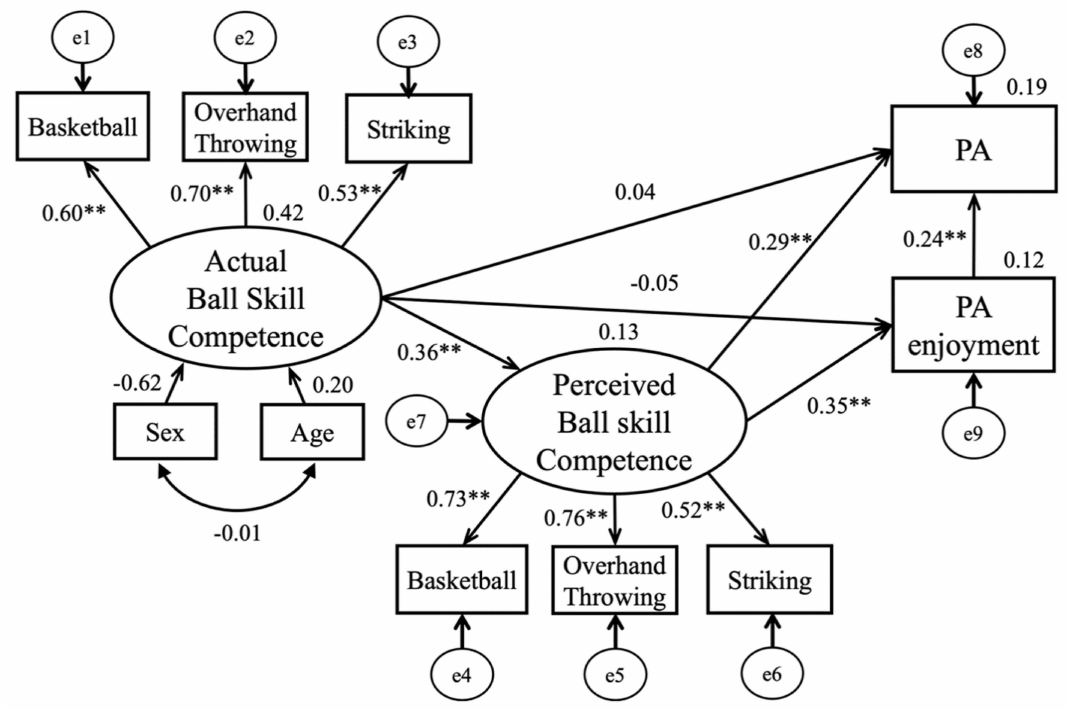
Figure 1. The Mediation Model with Standardized Path Coefficients. Note. ** p <